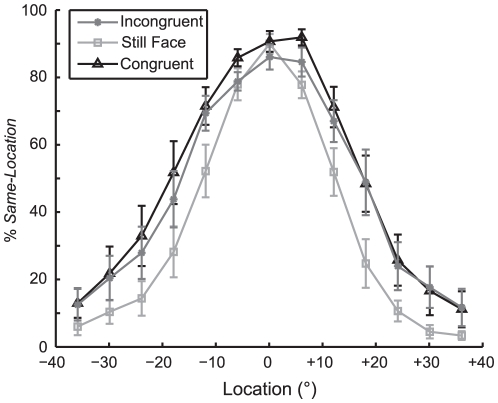
Speech cues affect audiovisual integration in space.(A) The percentage of Same-Location responses is plotted as a function of location for each condition: Congruent (black triangles), Incongruent (dark gray, asterisk), and Still Face (light gray, squares). Importantly, the likelihood of spatial integration (i.e. responding Same-Location) decreases at the smallest disparities in the Incongruent relative to the Congruent condition. (N = 11, means ± SEM).